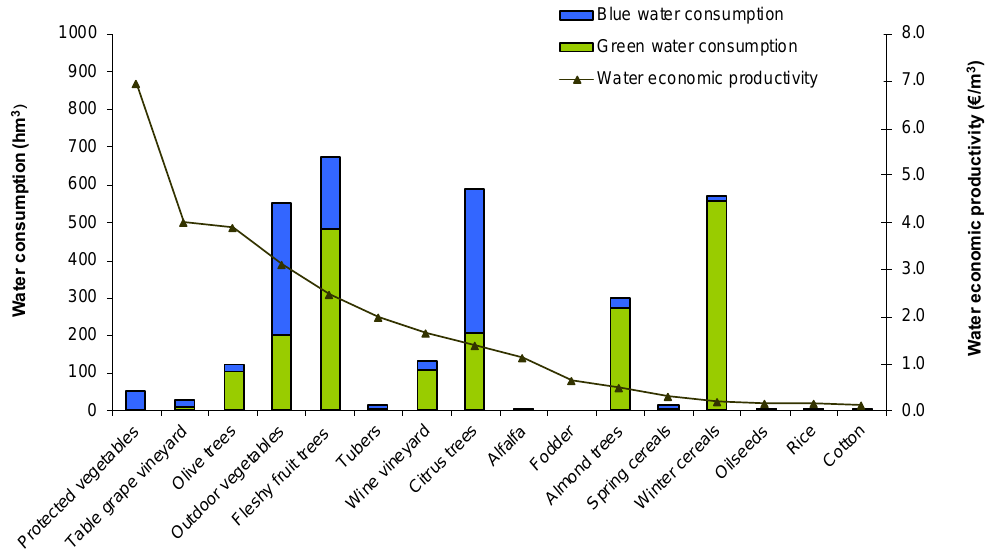
Figure 2. Blue and green water consumption and blue water economic productivity in the Segura basin. Source: Aldaya et al. [35].